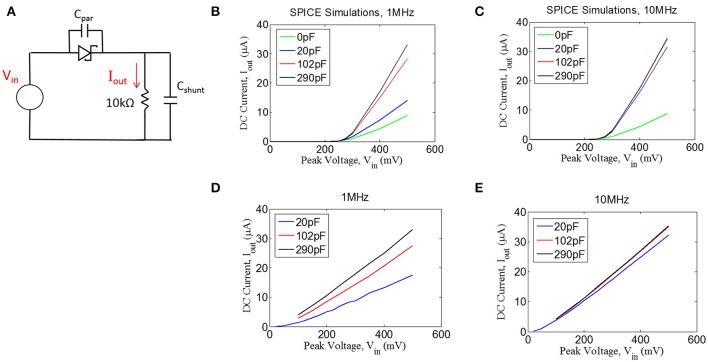
(A) Quantifying rectification by applying an AC signal (Vin) and measuring the time-averaged mean of the current, Iout, through a resistive load for different values of shunt capacitance (Cshunt) for 1 MHz (B,D) and 10 MHz (C,E). (B,C) Spice simulations showing for the circuit shown in (A), assuming a parasitic capacitance of the diode (Cpar) of 0.2 pF. (D,E) Experimental measurements with an RF Schottky diode.